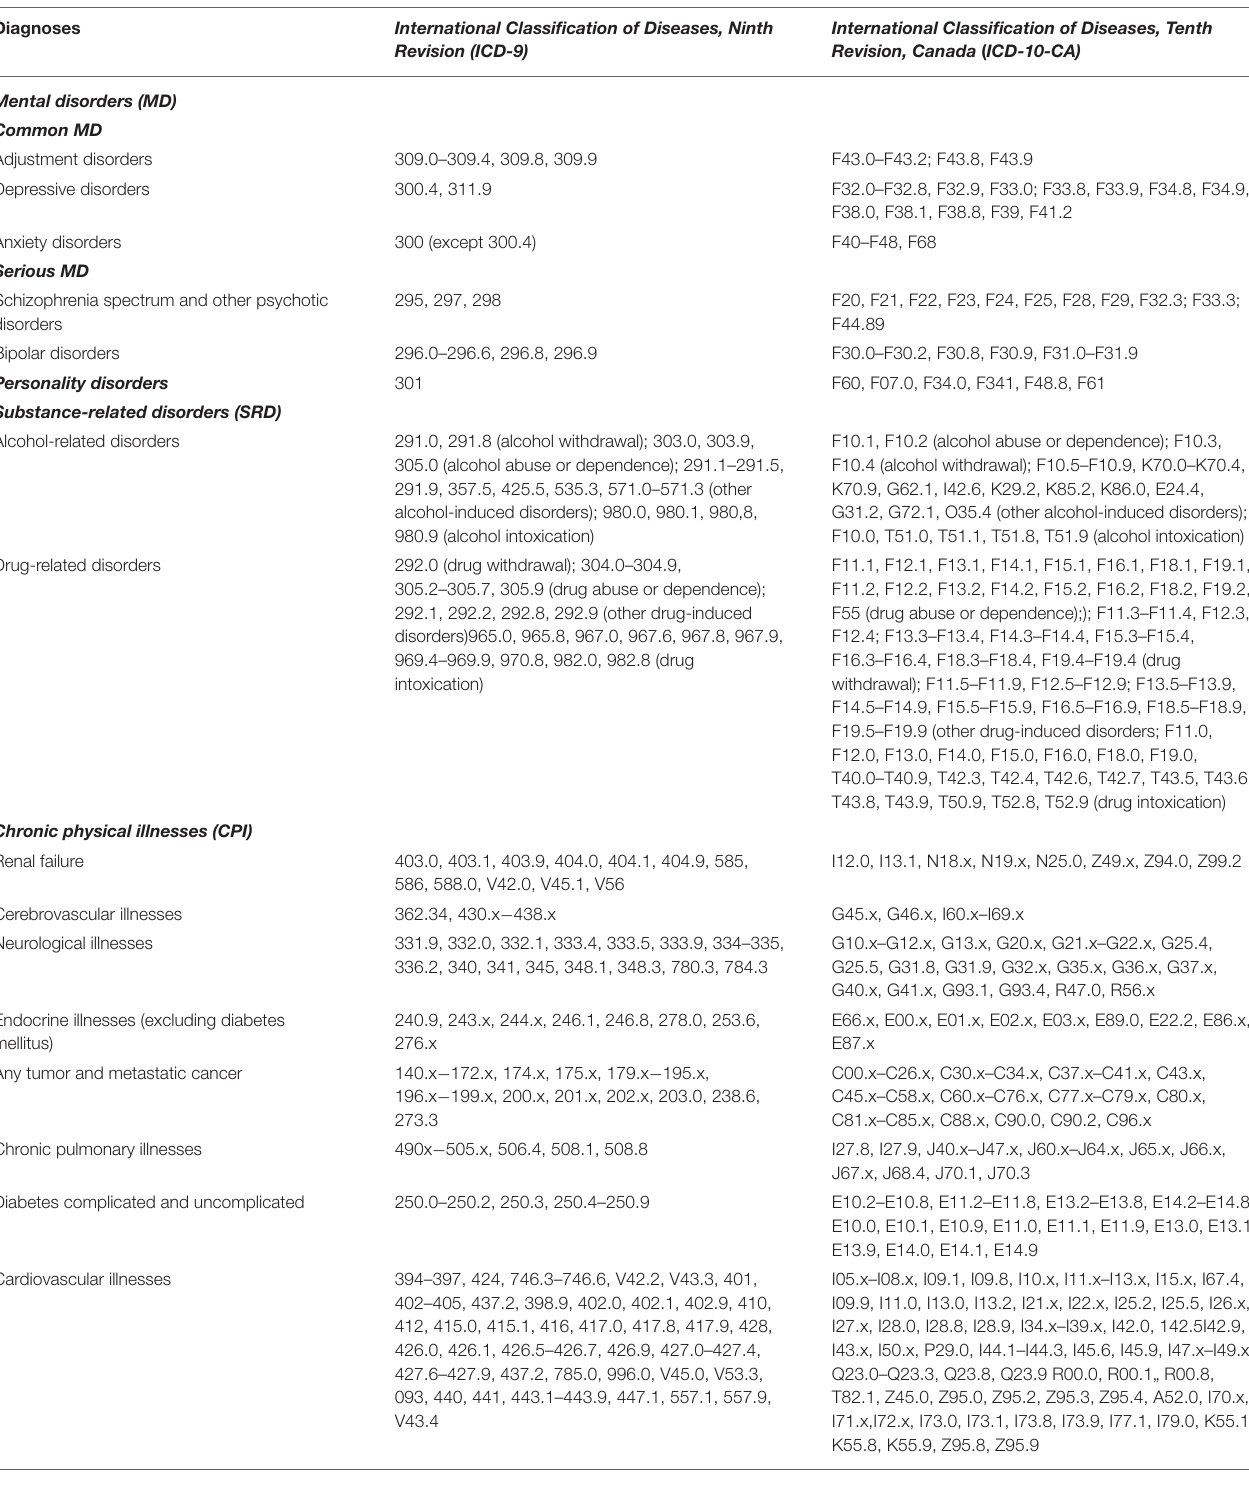
TABLE 1 | Codes for mental disorders (MD), substance-related disorders (SRD), and chronic physical illnesses (CPI) according to the International Classification of Diseases, Ninth and Tenth revisions a